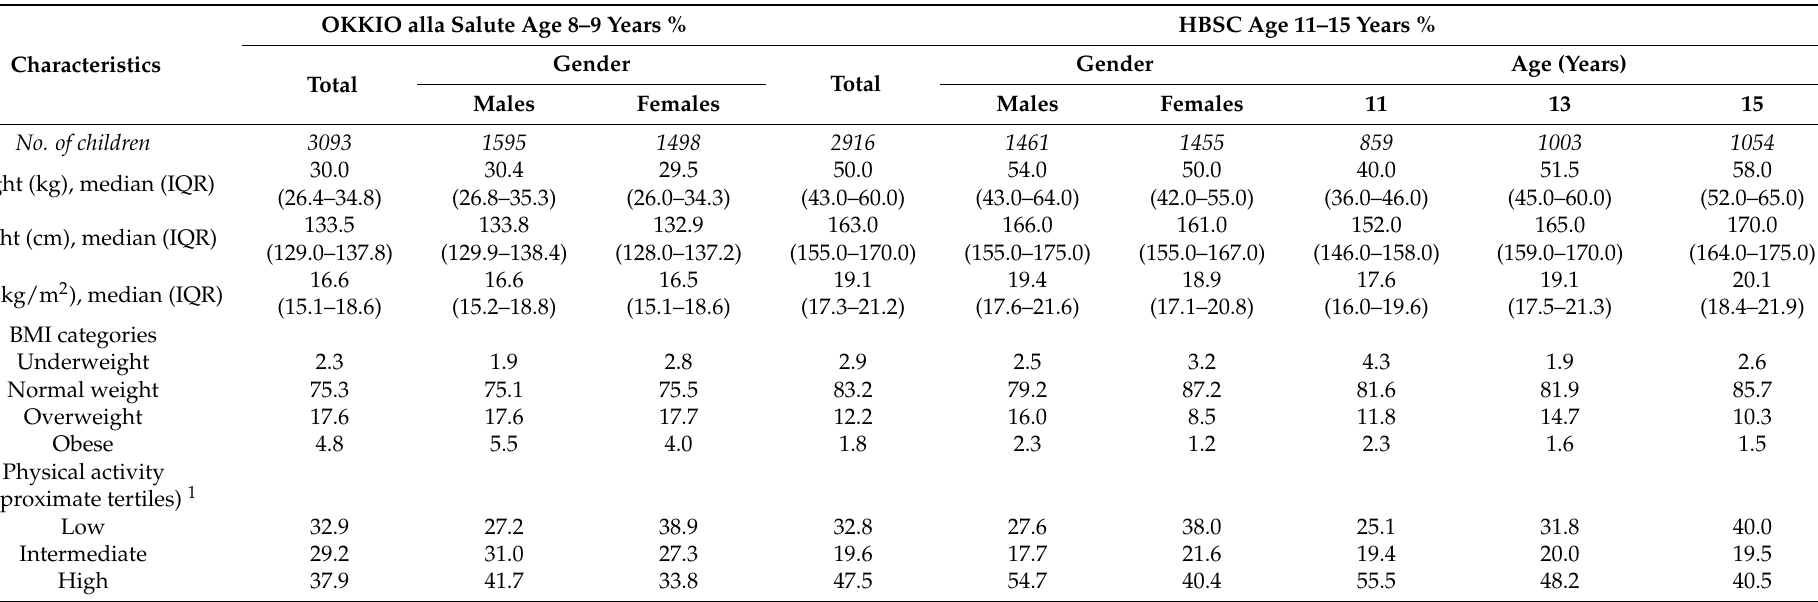
Table 1. Percentages (%) of children from the OKKio alla Salute and HBSC surveys, according to various anthropometric measures. Lombardy,